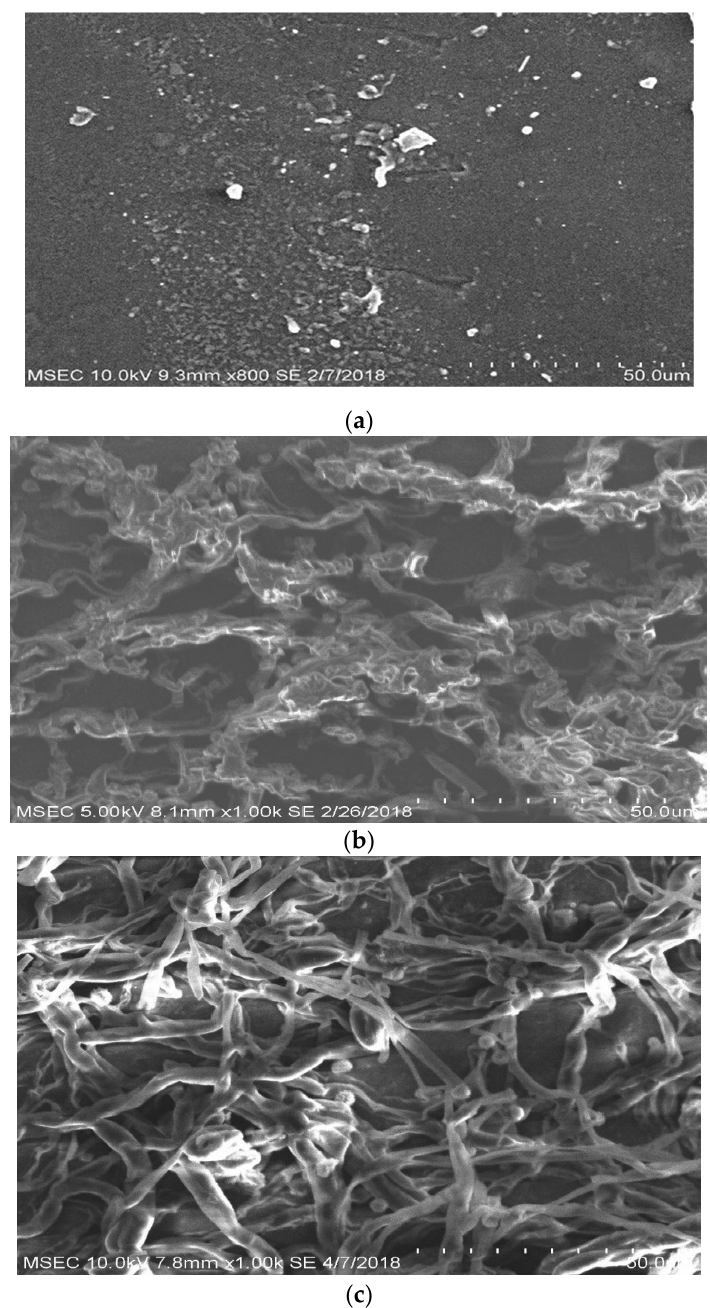
Figure 3. SEM images of S5 ( a ) before degradation, ( b ) degradation depth at 2 cm, and ( c ) degradation depth at 3 cm.